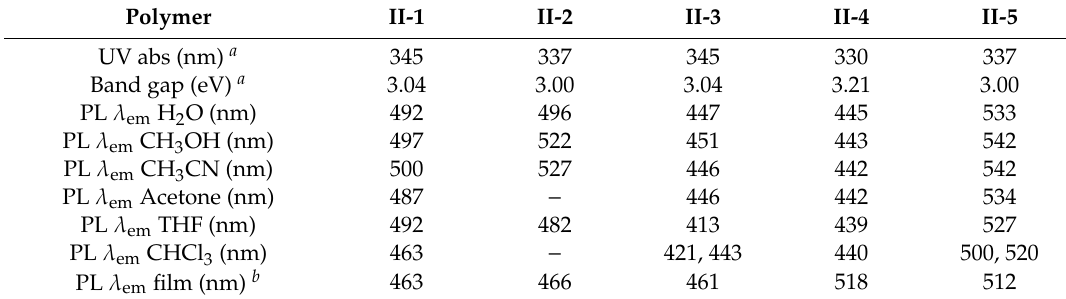
Table 3. Optical properties of poly(pyridinium) salts with macrocounterions, II-1 – II-5.